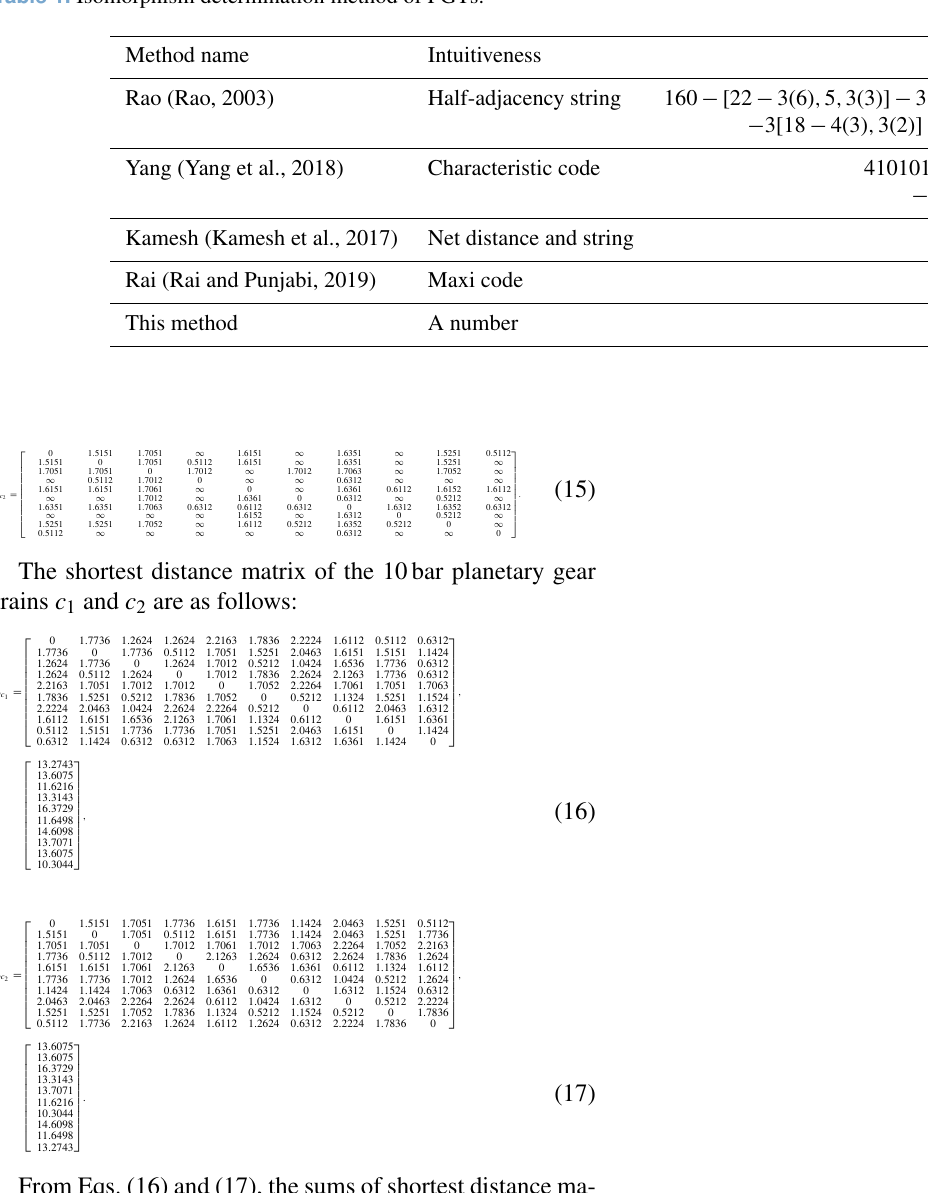
Table 1. Isomorphism determination method of